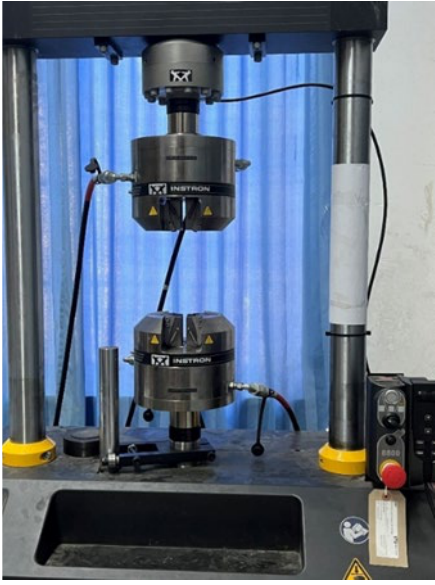
Figure 2. Instron 8801 electro-hydraulic servo fatigue testing machine.